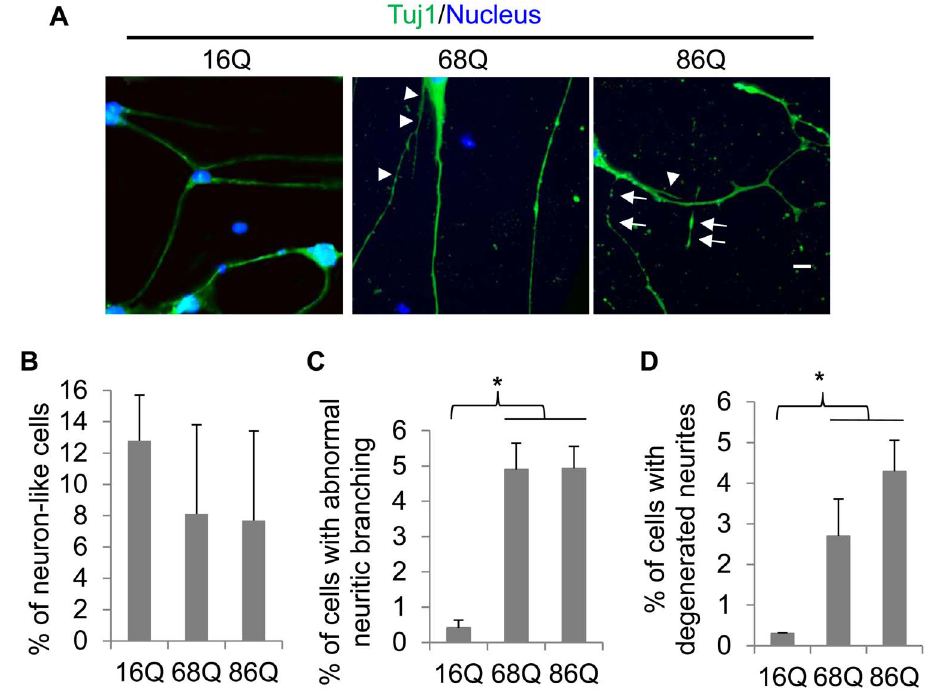
Figure 1. Direct conversion of HD patient fibroblasts into neuron-like cells. Human fibroblasts derived from a normal individual (16Q) or HD patients (68Q and 86Q) were infected with lentiviral shRNAs against human PTB. Nineteen days following the treatment, cells were used for analyses. ( A ) Immunostaining of the trans-differentiated cells with a neuron-specific marker, Tuj1, antibody. Arrow heads indicate thin or short neurites and arrows show broken neurites. Scale bar, 10 m m. Cell counting results showing the percentage of cells with neuron-like morphology positive in Tuj1 staining ( B ) , with abnormal neurites ( C ) , or with degenerated (breakdown) neurites ( D ) . Data are shown as mean 6 SD; n=3. *p , 0.05.